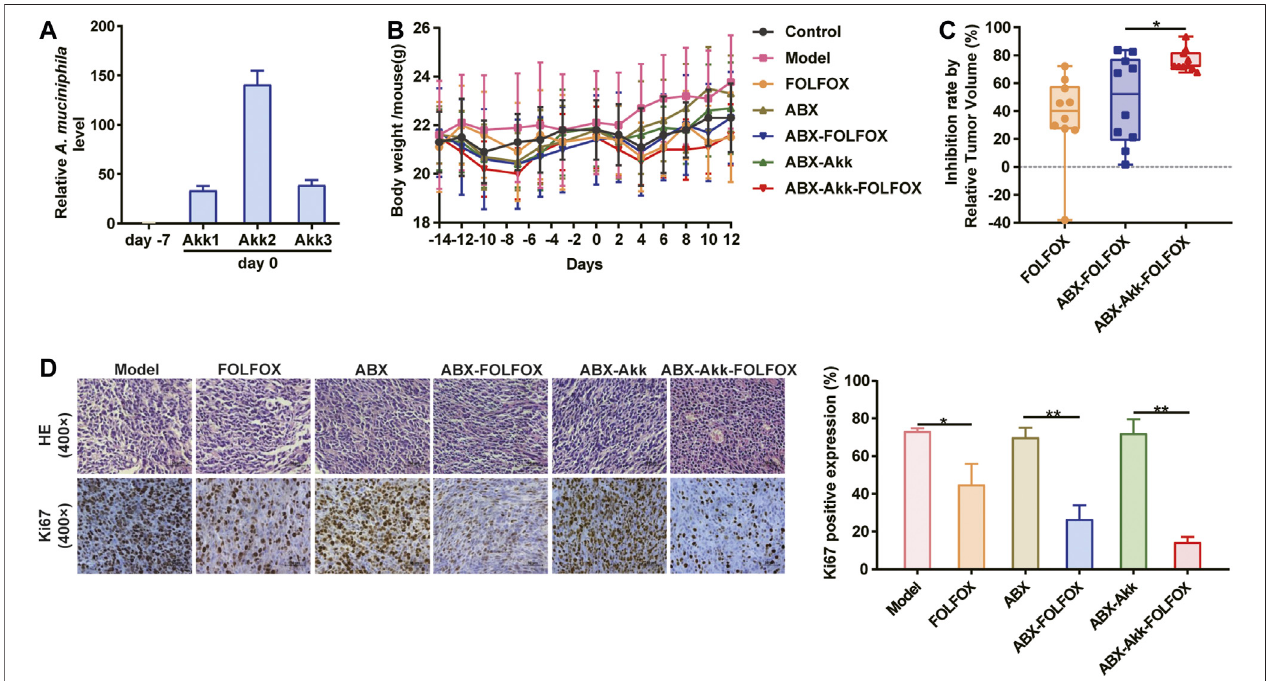
FIGURE4 | A. muciniphila colonization signi fi cantlyenhanced the anti-cancer effect ofFOLFOX. (A) Relative abundance of A. muciniphila before (day − 7) and after (day 0) the transplantation. (B) Change of the body weight of tumor-bearing mice across the experiment. (C) Inhibition rate by RTV were calculated: Model vs. FOLFOX (36%), ABX vs. ABX-FOFOX (48%) and ABX-Akk vs. ABX-Akk-FOLFOX (76%). (D) The percentage of Ki67 positively stained cells. Data were presented as mean ± SD. The p -values < 0.05 were considered statistically signi fi cant, * p < 0.05, ** p < 0.01.